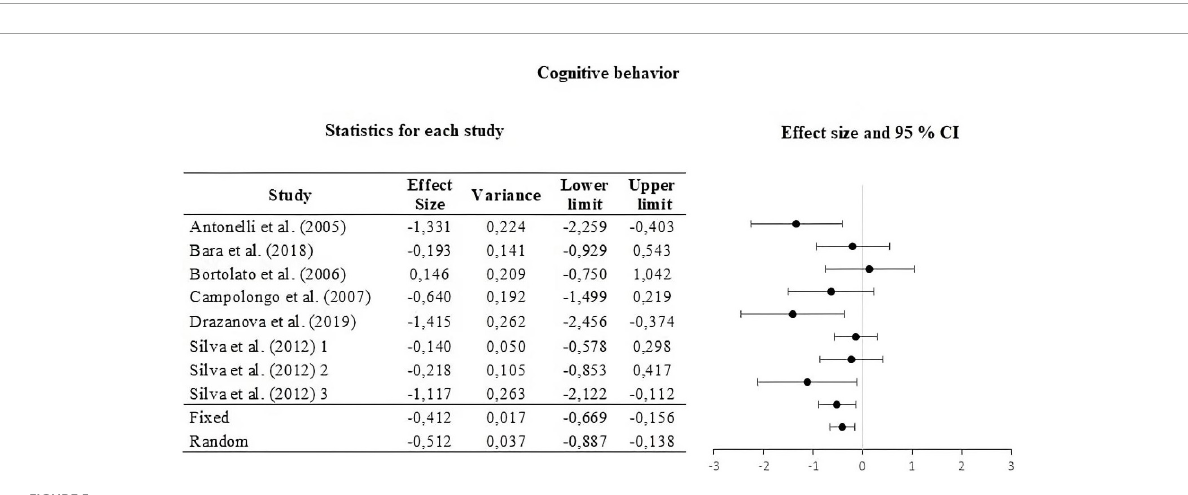
FIGURE5 Forest plot of the effect sizes and estimated confidence intervals of the UAs that evaluated cognitive behavior. For the integrated effect size Cohen’s d was used. The lines indicate the effect sizes of each UA and its corresponding 95% confidence intervals. The last two lines represent the result under a fixed and random effect model, respectively. The lower and upper limits and the variance of each UA are